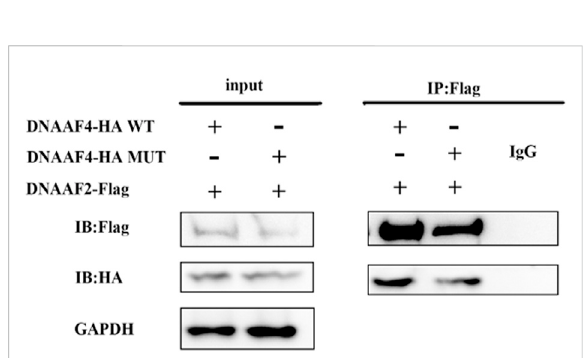
FIGURE 5 Interaction of the Mutated and Normal DNAAF4 Protein with DNAAF2protein.DNAAF4representsanewcytoplasmicaxonemal dynein assembly factor, acting together with DNAAF2 at an early step in cytoplasmic ODAs and IDAs assembly. HA-tagged DNAAF4 was co-expressed with Flag-tagged DNAAF2 in HEK293T cells for Forty-eight hours. Extracts